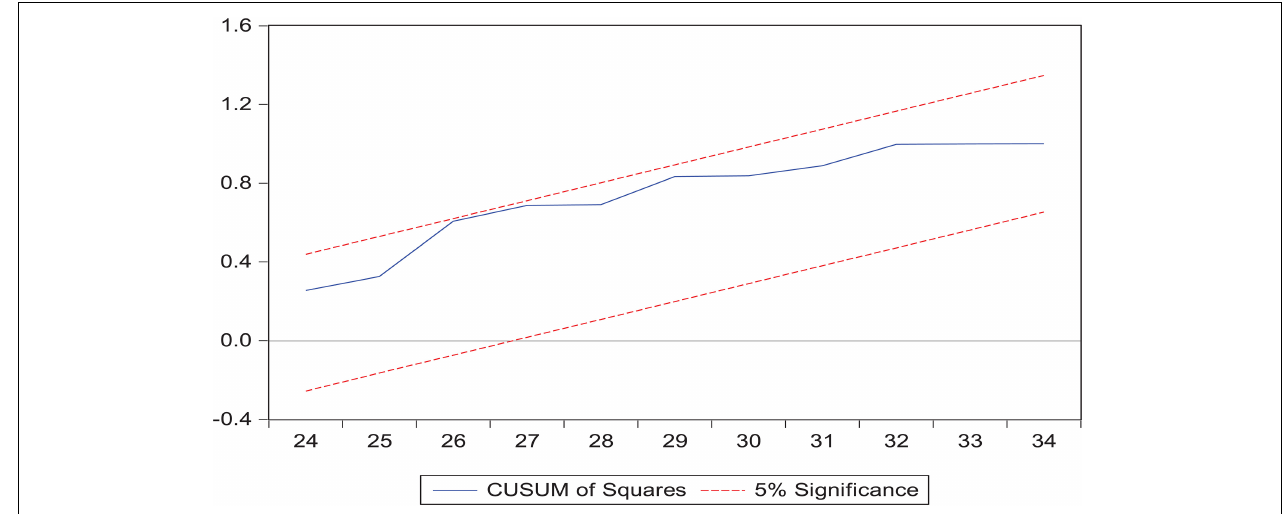
FIGURE 3 | Cumulative sum of squares of residuals.